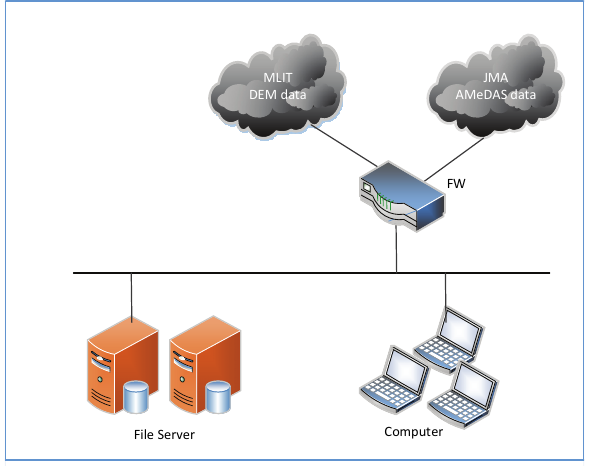
Figure 6. System configuration